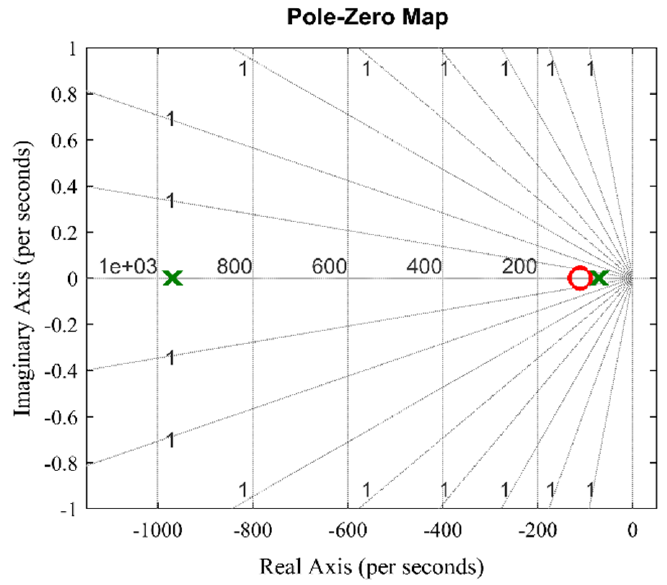
Figure 8. Pole-zero plot of closed-loop transfer function of q − axis current controller.